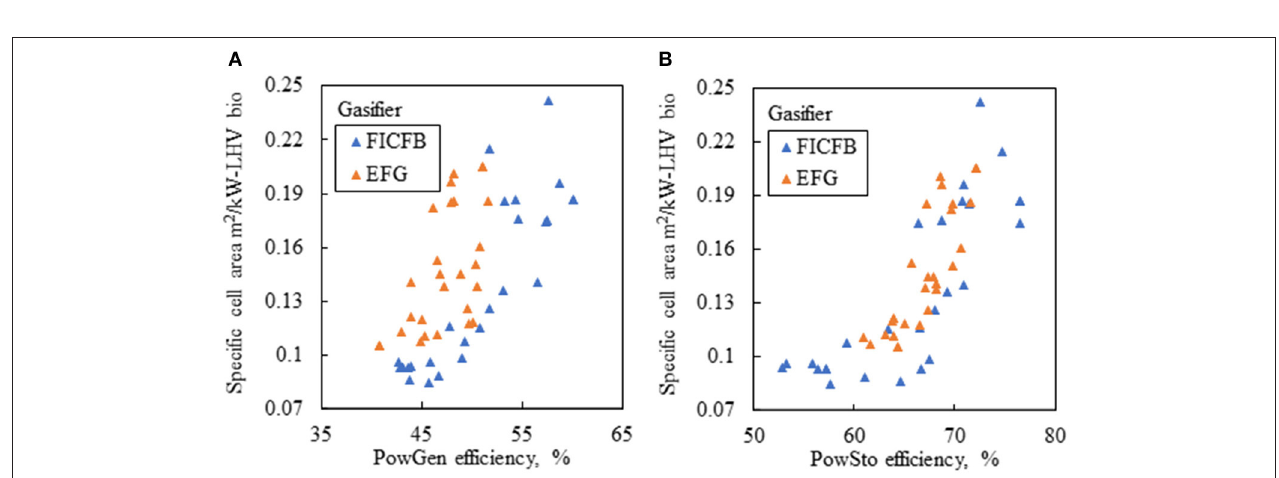
FIGURE 4 | The grid flexibility needs: (A) Geographic locations and (B) theoretical and scaled flexibility needs.